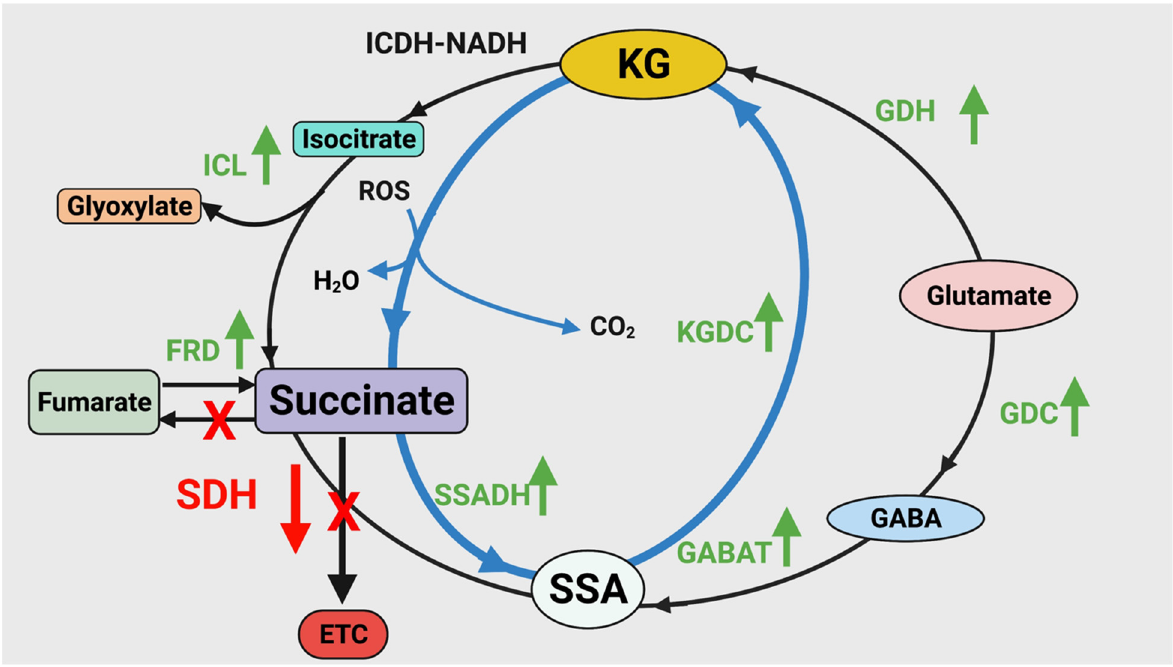
Figure 5. Schematic representation of the metabolic pathway used by P. fluorescens to combat sulfur starvation. The dicarboxylic acid is regenerated into KG by SSADH and KGDC. The enzymes ICL and FRD contribute to the succinate pool of succinate while GDC and GABAT maintain SSA homeostasis. ICL = isocitrate lyase, FRD = fumarate reductase, SSADH = succinate semialdehyde dehydrogenase, SDH = succinate dehydrogenase, KGDC = α -ketoglutarate decarboxylase, GABAT = GABA transaminase, GDC = glutamate decarboxylase, GDH = glutamate dehydrogenase, KG = α - ketoglutarate, SSA = succinate semialdehyde. = Cycle producing KG from glutamate, =